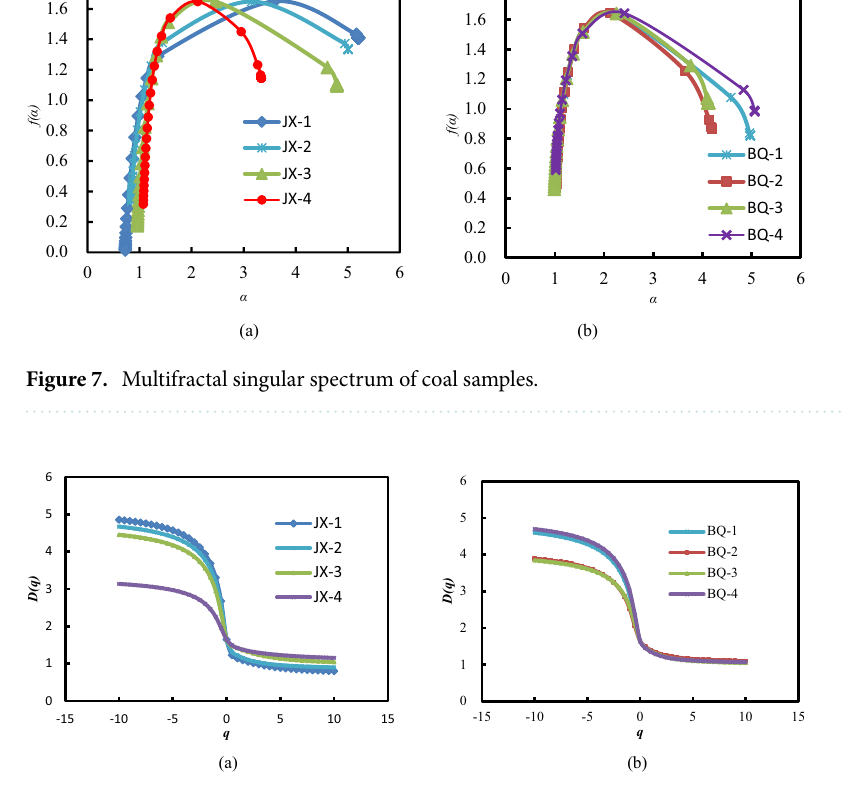
Figure 8. Generalized fractal dimension